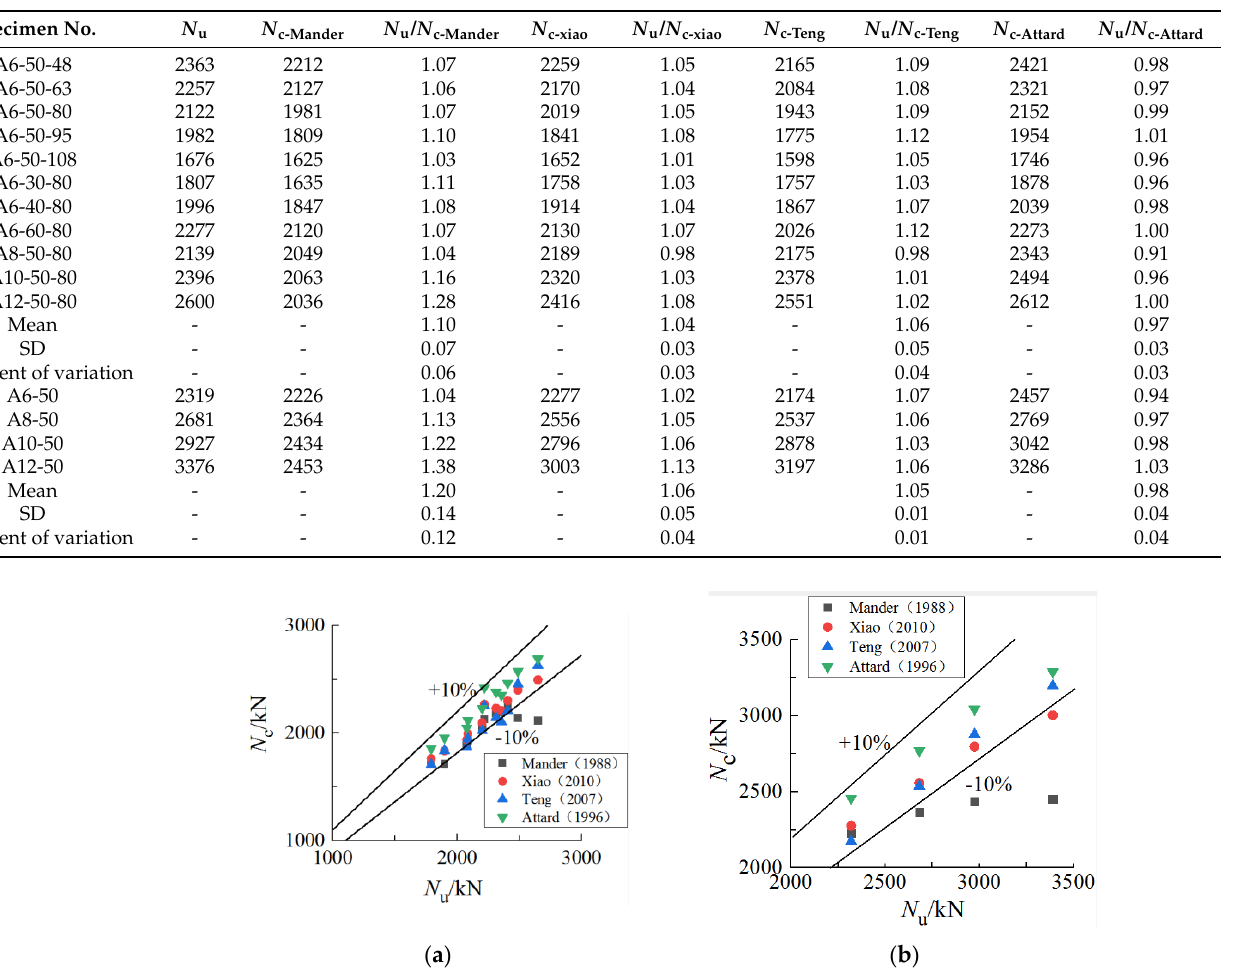
Figure 17. Comparison of axial compressive strength predictions. ( a ) ATCC-CHS, ( b ) ATCC. Table 5. Ultimate strength of the tested specimens.